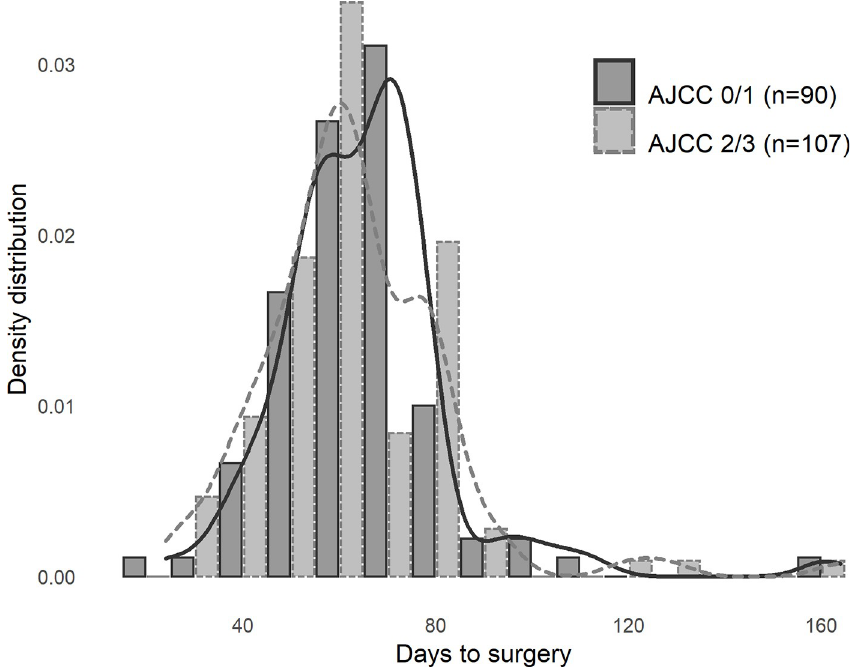
Fig 1. Delay to surgery by tumour regression grade. Histogram, in 5-day bins, illustrating distribution of time between completion of radiotherapy and surgery, stratified by AJCC regression grade, overlaid by a kernel density plot. No significant between group differences (p =